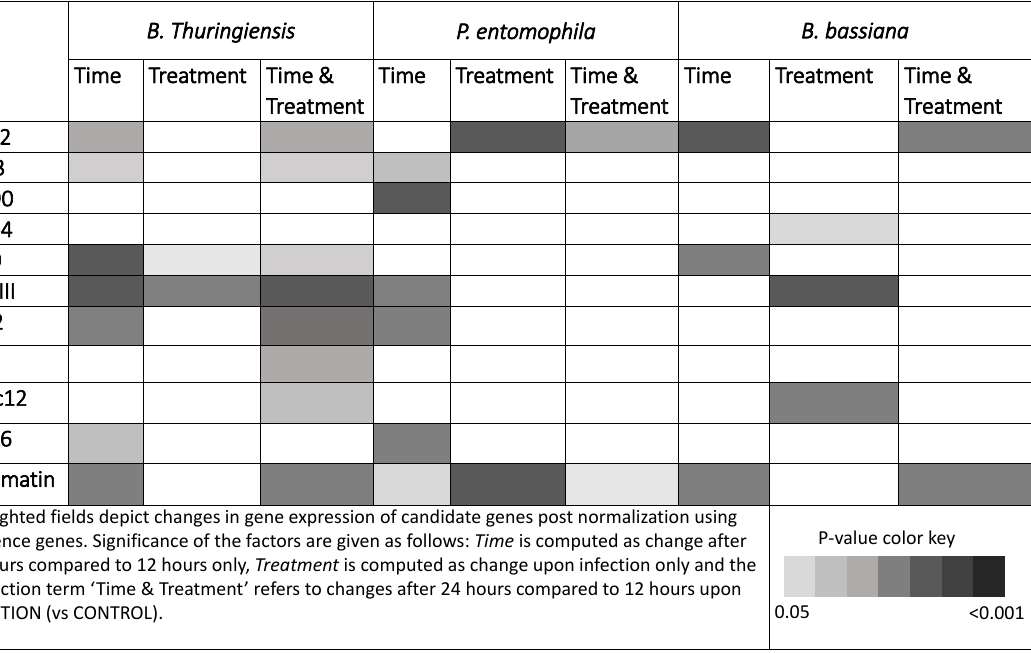
Figure 3. Results from the analysis of differential relative gene expression upon parasite exposure via generalized linear mixed models performed using the R package MCMC.qpcr [47,48]. See Supplementary Materials File 5, Table S2 for corresponding p